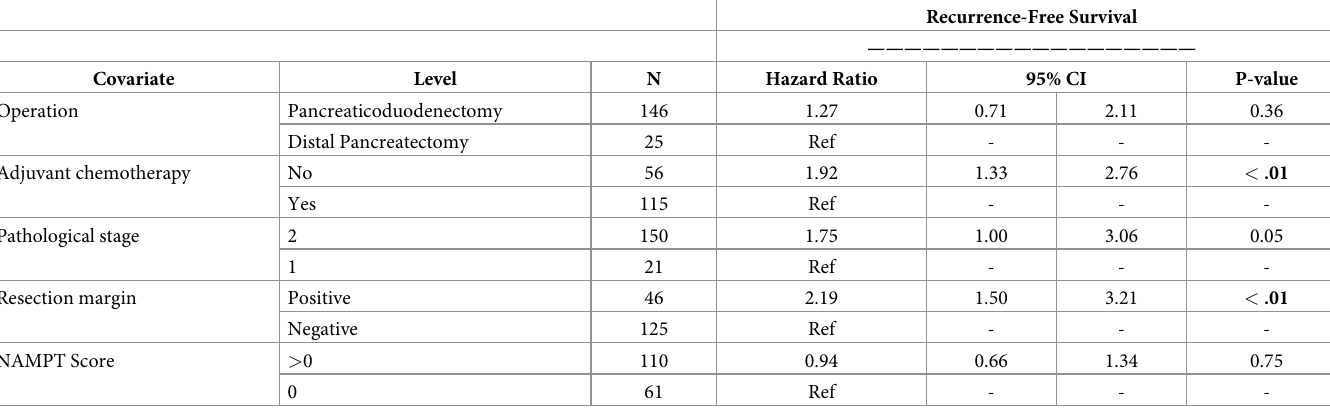
Table 5. Multivariate analysis for recurrence-free survival.